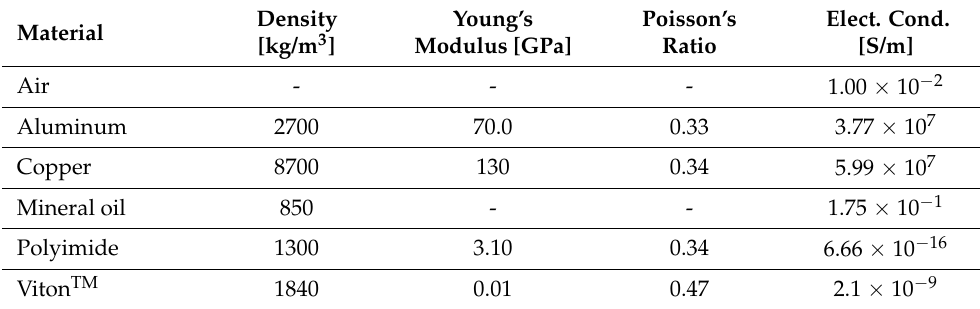
Figure 4. Model geometry of LC sensor and readout coils and Magnetic field distribution at 13 MHz excitation. Assumed material properties for FEA given in Table 4. Table 4. Assumed material properties for FEA.